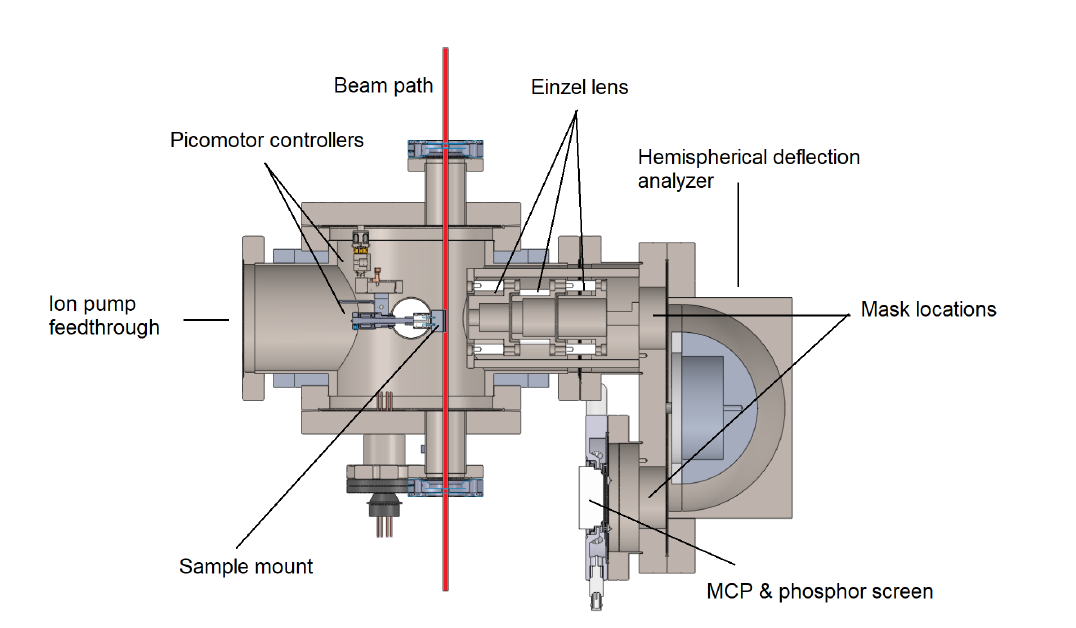
Figure 9. Schematic drawing of the electron spectrometer, including its three main components: einzel lens, HDA, and multichannel plate (MCP)